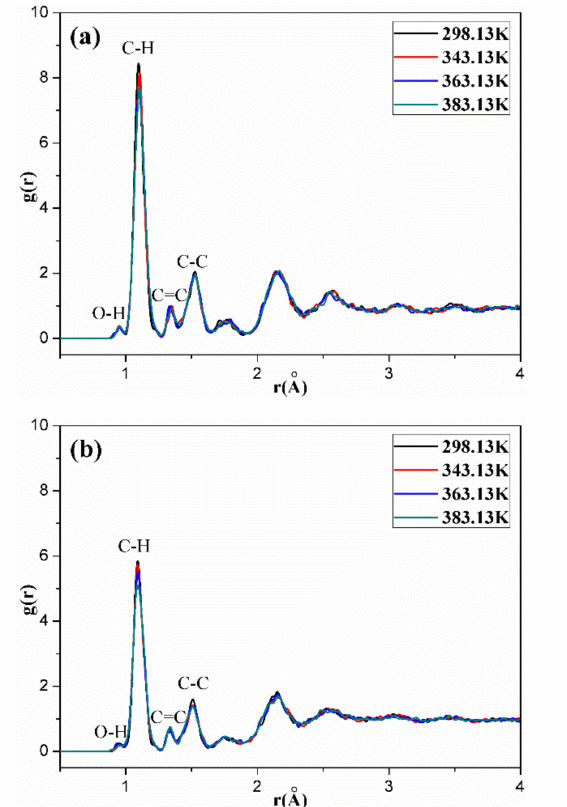
Figure 14. The radial distribution functions (RDFs) of carbon atoms (C–C) in the OH-CO-NBR model in the uncompressed ( a ) and compressed ( b ) states.